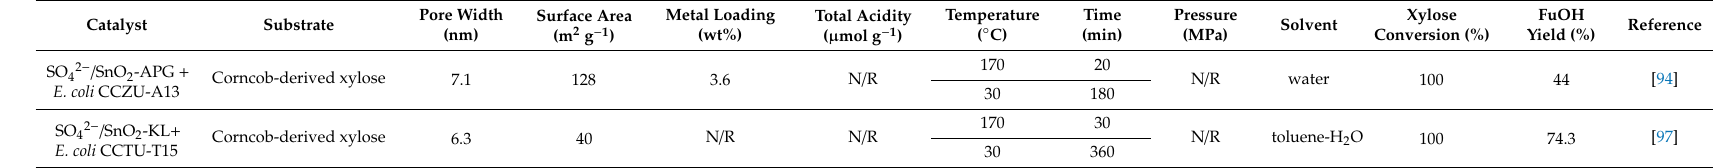
Table 3. Production of FuOH from biomass-derived xylose in one-pot